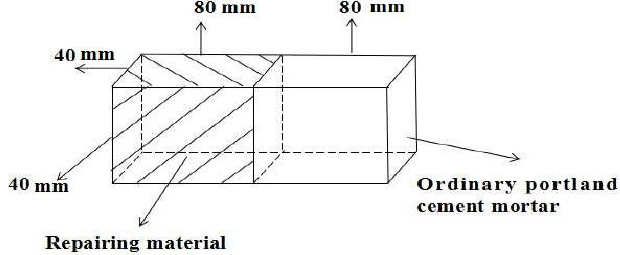
Figure 2. Specimen for the measurement of bond strength.